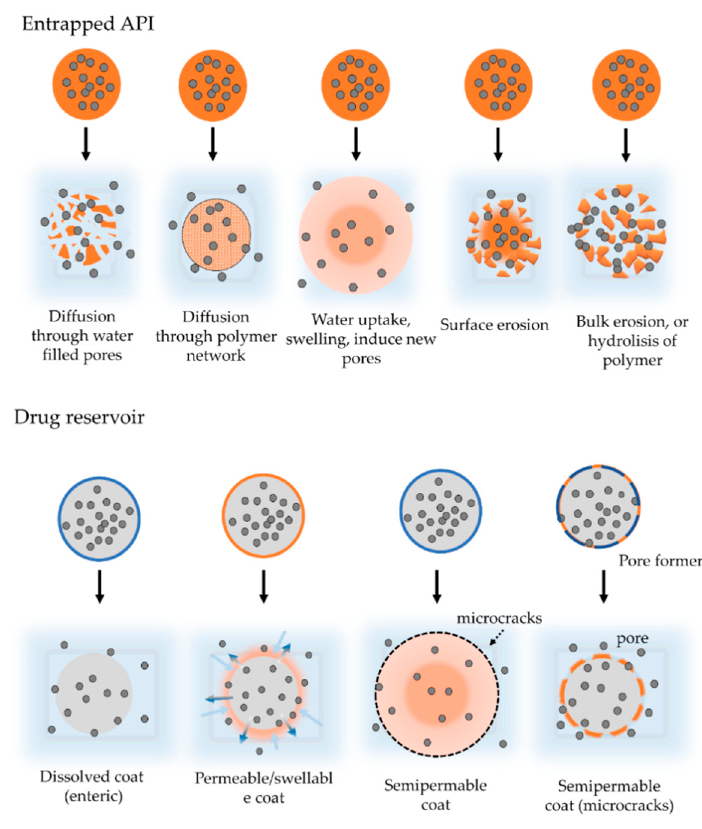
Figure 3. Release mechanisms in microencapsulated products.